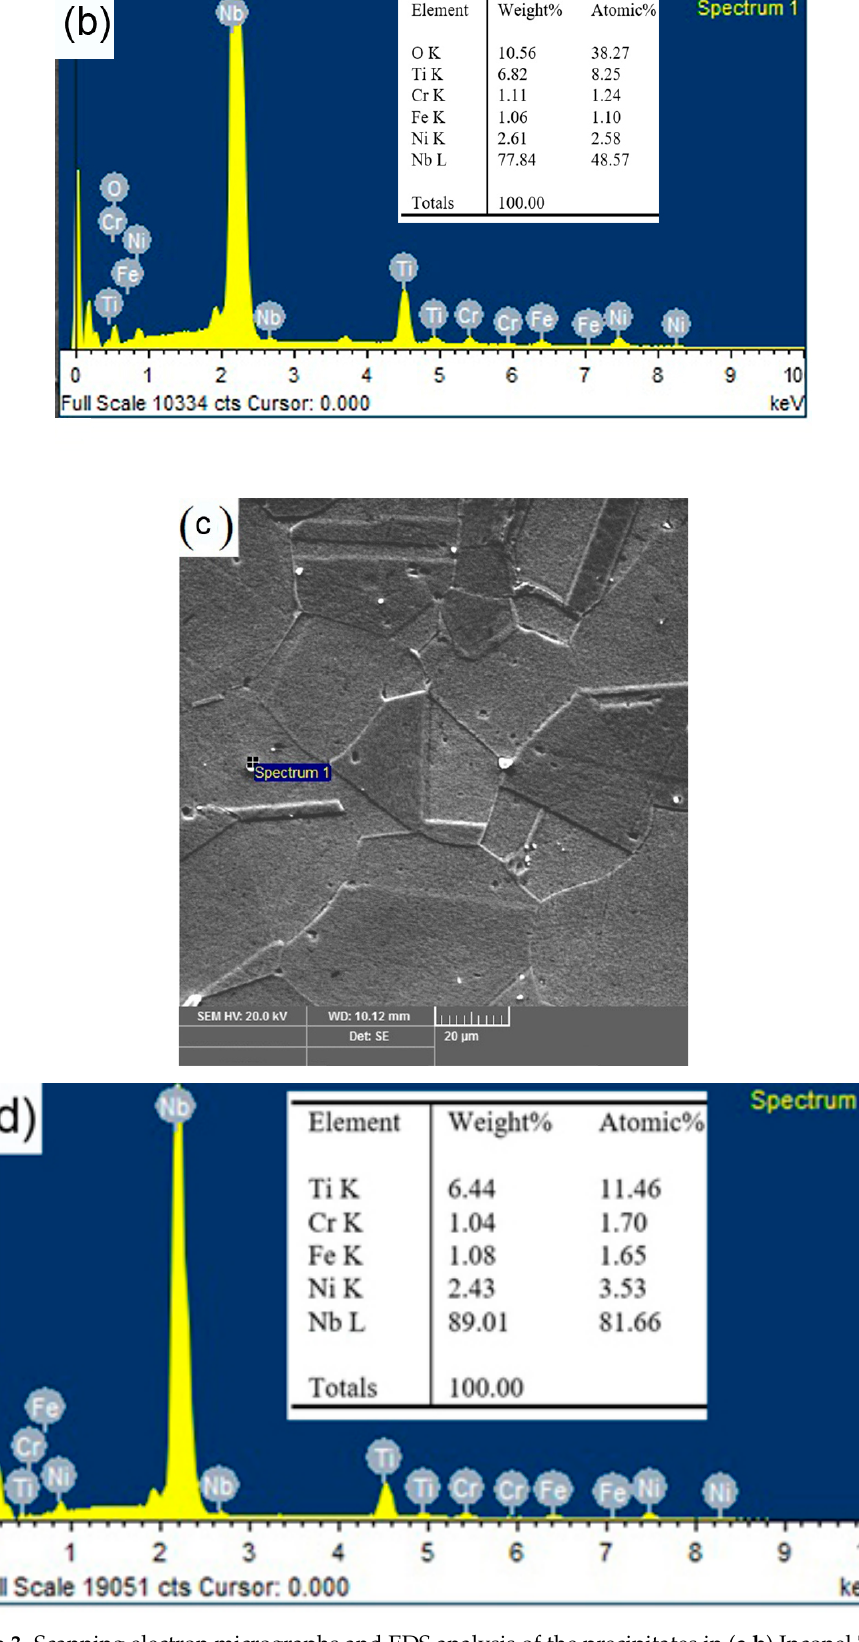
The macrographs of the typical dissimilar friction-welded joints of AISI 316L/IN 718 ST and AISI 316L/IN 718 STA are shown in Figure 4a,b, respectively. The weld joints have good flash, suggesting that the heat generated by frictional forces is sufficient to plasticize the metals at the interface. The higher flash on the AISI 316L side and less flash on the IN 718 side may be due to the drop-in flow stresses of AISI 316L at elevated temperatures. The extent to which IN 718 and AISI 316L deform as a flash is dependent on their YS at high temperatures. As IN 718 has higher strength compared to AISI 316L, AISI 316L has more flash than IN 718. Native oxides and other impurities present on the base metal surface are removed in the form of plasticized material. The forge/upset pressure is high enough to extrude the plasticized material out of the weld joint, resulting in a sound weld joint without any cracks, as shown in the visual view of AISI 316L/IN 718 ST and AISI 316L/IN 718 STA in Figure 4c,d, respectively. Friction welding has the advantage of requiring fewer requirements for welding surfaces. Impurities on the surfaces are forced away, ensuring the contact between surfaces is free from contaminants, resulting in a sound and defect-free weld. However, this idealistic situation fails when two base materials with distinct flow properties are combined. The absence of metal flow on one side, as indicated by the presence of material, impedes the desired cleaning action. However, in the present work, there was some deformations observed in Inconel 718 side (Figure 4a,b), somewhat alleviating the self- cleaning problem, resulting in a weld joint free of delaminated regions and welding defects.